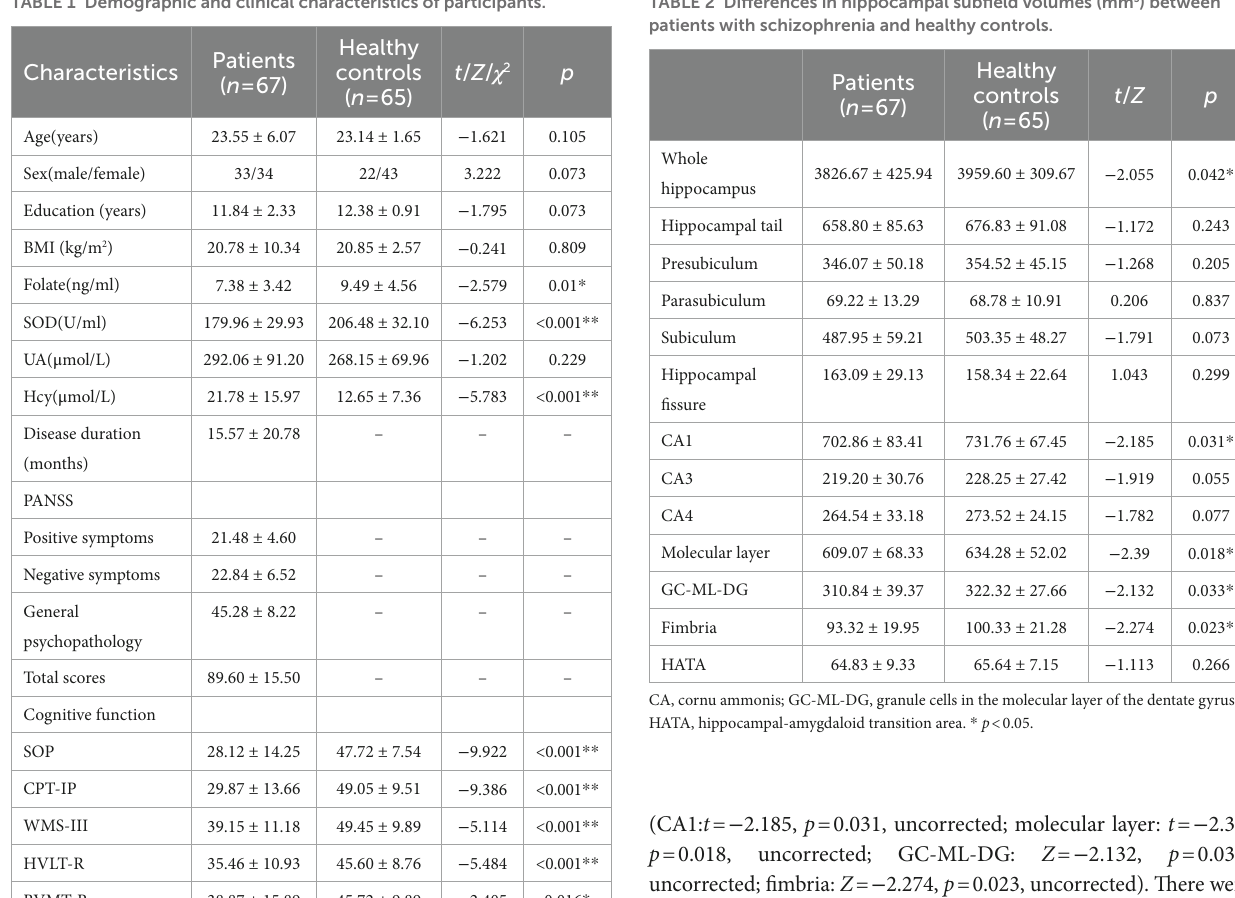
TABLE 2 Differences in hippocampal subfield volumes (mm 3 ) between patients with schizophrenia and healthy